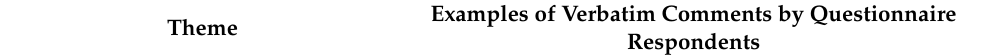
Table 5. Open-ended responses to the questionnaire rating restaurant/caf é employee staff knowledge about